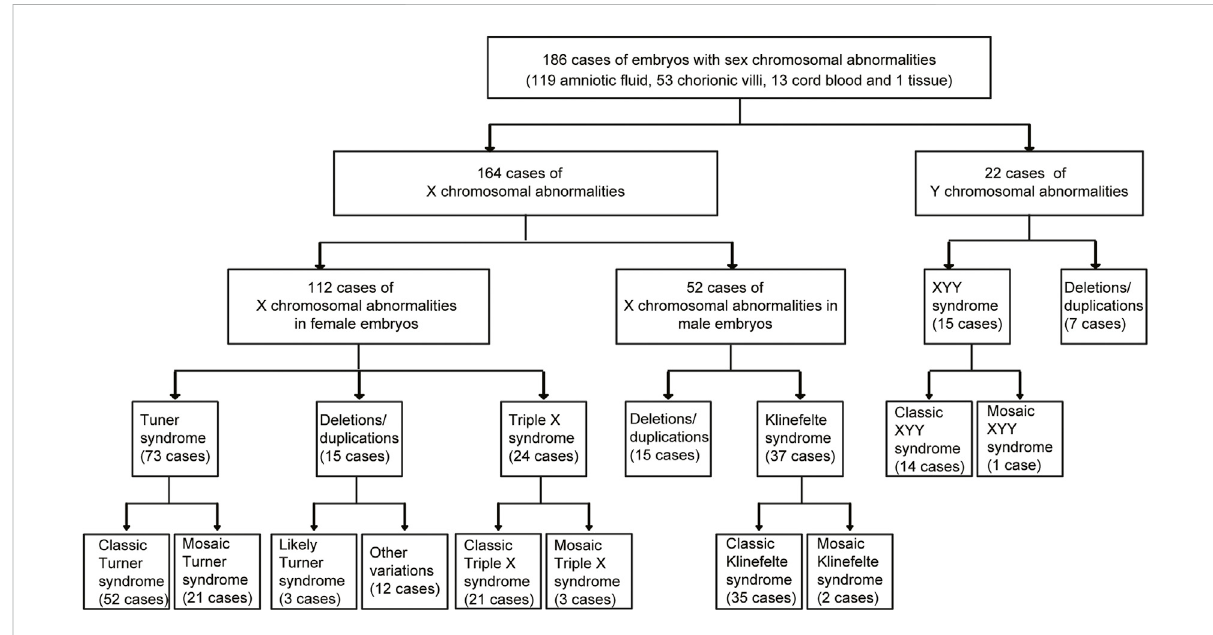
FIGURE 1 Retrospective analysis of 186 fetuses with sex chromosomal